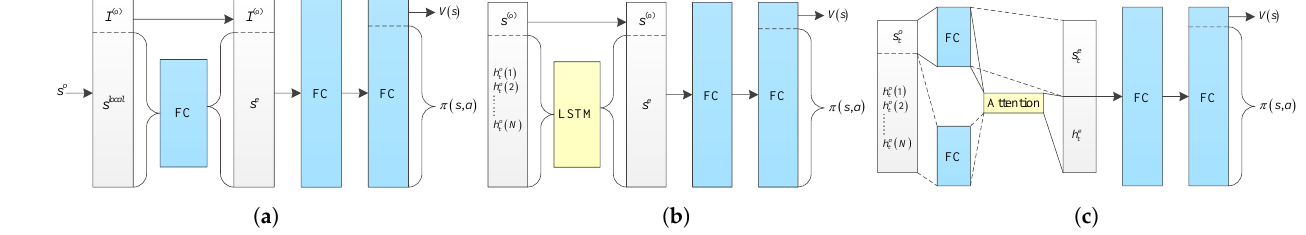
Figure 10. Attention network architecture evolutionary process. ( a ) Fully connected structure. Reprint with permission from [27]. 2019, IEEE; ( b ) LSTM structure. Reprint with permission from [28]. 2021, Peng; ( c ) Attention network architecture. Reprint with permission from [29]. 2020, Peng. In [38], the graph convolutional neural network (GCN) [55] is applied, and a feature matrix X ∈ R N × D and three adjacency matrices A ∈ R N × N are taken as inputs, where N is the number of aircraft and D is the input dimension, as shown in Figure 11. Implementing three parallel graph-based layers with different adjacency matrices allows the aircraft to understand its surrounding on multiple levels. The first adjacency matrix takes global information into account, allowing each aircraft to always have a view of its surrounding. The second adjacency matrix only takes aircraft into account inside the detection area. The third adjacency matrix only takes aircraft into account inside the penalty area, providing more information if aircraft are closer.